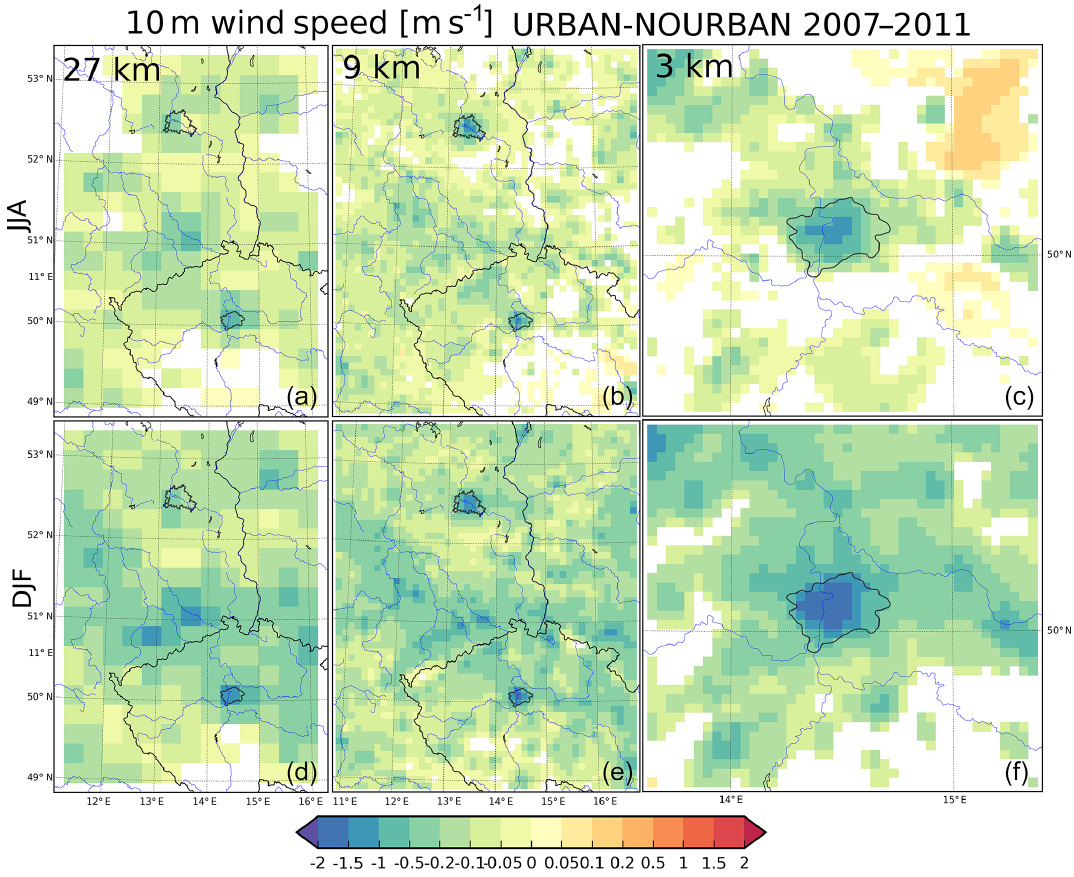
Figure 11. Impact of urban surfaces on 10m wind speed in ms − 1 for JJA (a, b, c) and DJF (d, e, f) for the three resolutions (27, 9 and 3km). Shaded areas represent statistically significant changes over the 98% threshold using a two-tailed t test. The geographic locations of Berlin and Prague are indicated by their administrative